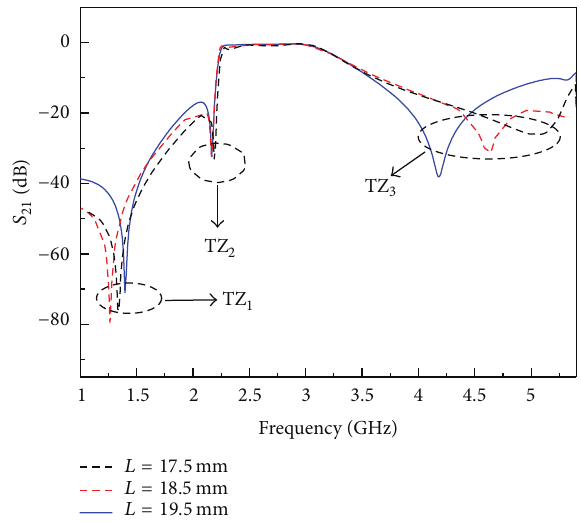
Figure 4: The changes of transmission zeros versus L .